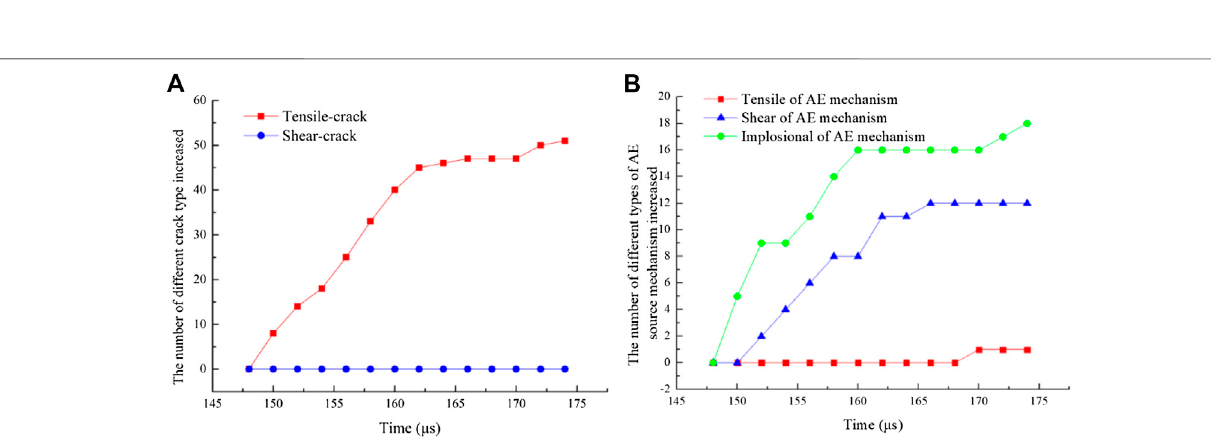
is tensile, which does not coincide with the HS photograph in Figure 8 . Figure 14A is the cumulative counts of different crack types obtained by bond break with the PFC simulation. The results